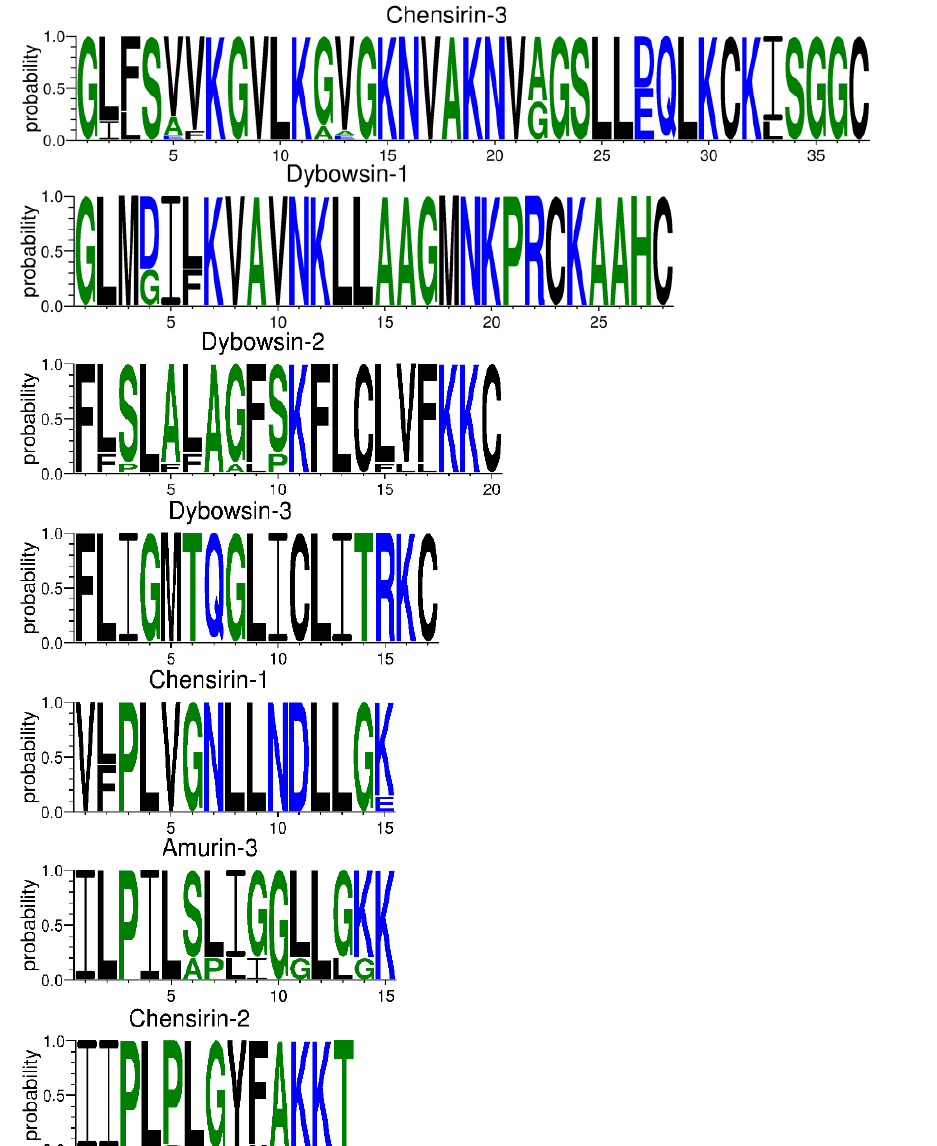
Figure 10. The primary structure of mature peptides of 7 antimicrobial peptide (AMP) families from R. dybowskii . The blue letters represent hydrophilic residues, including Arginine (R), Lysine (K), Aspartic acid (D), Glutamic acid (E), Asparagine (N), Glutamine (Q); the green letters represent neutral residues namely Serine (S), Glycine (G), Histidine (H), Threonine (T), Alanine (A), and Proline (P); the black letters represent hydrophobic residues, including Tyrosine (Y), Valine (V), Leucine (L), Isoleucine (I), Phenylalanine (F), Tryptophane (W), Methionine (M), and Cysteine (C). 63.6% sequences (14 out of 22) of chensirin-3 had deletion of a short fragment spanning site 19 to 22; 80.0% sequences (1 out of 5) of amurin-3 had an amino acid deletion at site 15.